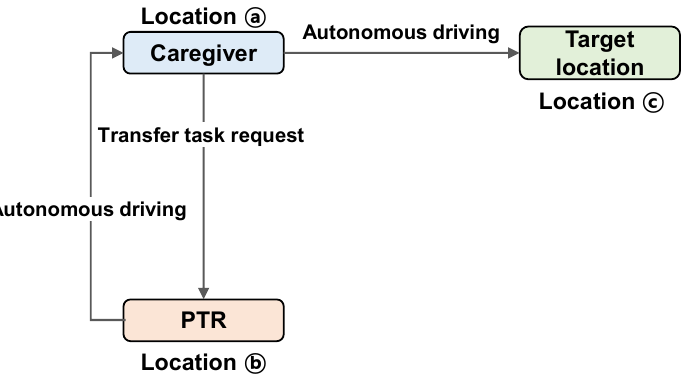
Figure 17. Simulation scenarios.